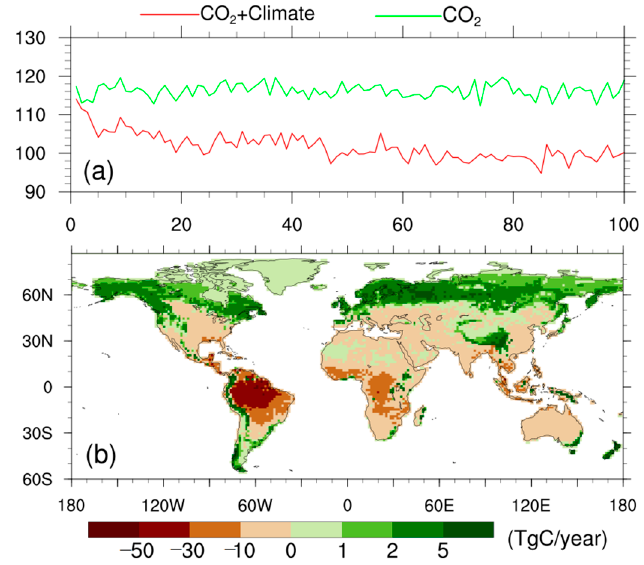
Figure 8. ( a ) Time evolutions of NPP (units: PgC year − 1 ) for the biogeochemically coupled simulation (green line) and the fully coupled abrupt-4 × CO 2 simulation (red line). ( b ) Spatial distribution of the differences in NPP (TgC year − 1 ) between the fully coupled abrupt-4 × CO 2 simulation and the biogeochemically coupled simulation for the last 20 years.